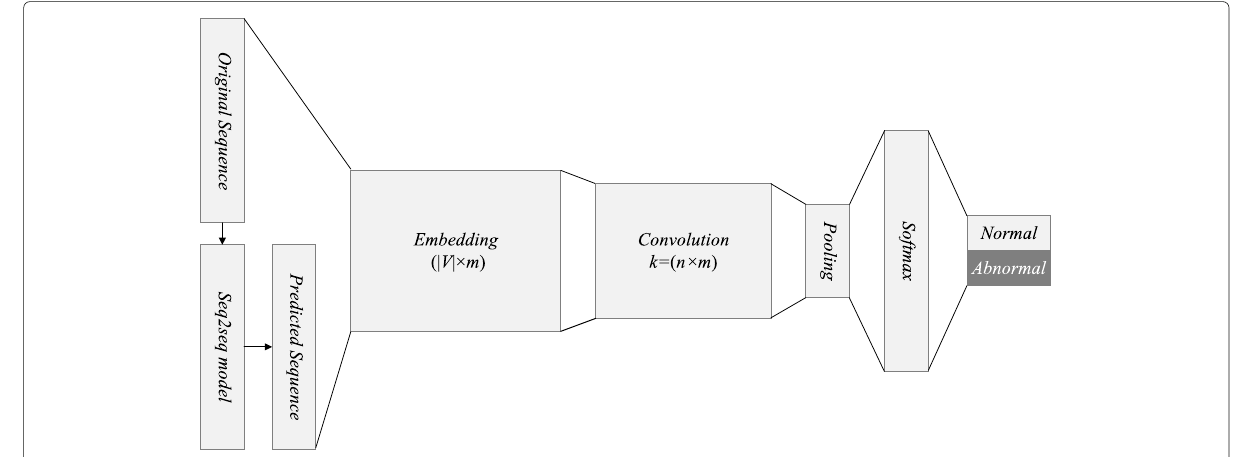
Fig. 4 CNN classification for anomaly intrusion detection trained based on the extended system call